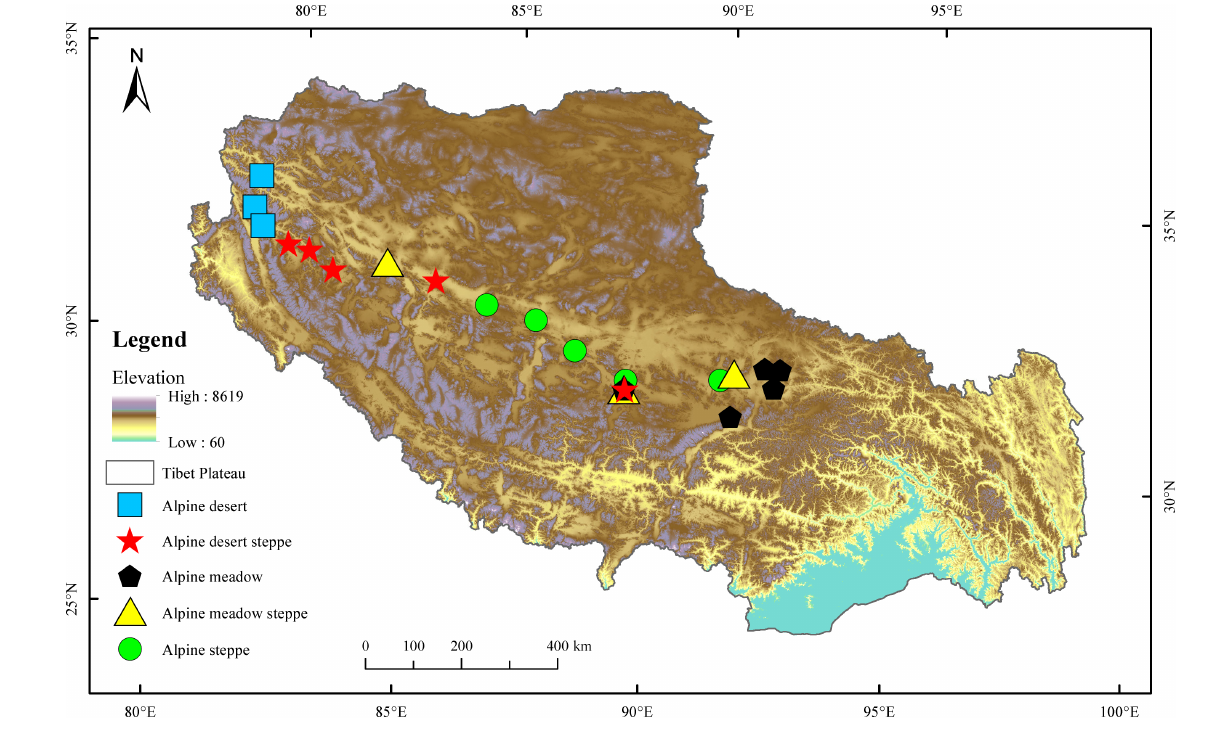
FIGURE 1 | Sampling sites of alpine grasslands on the Tibetan